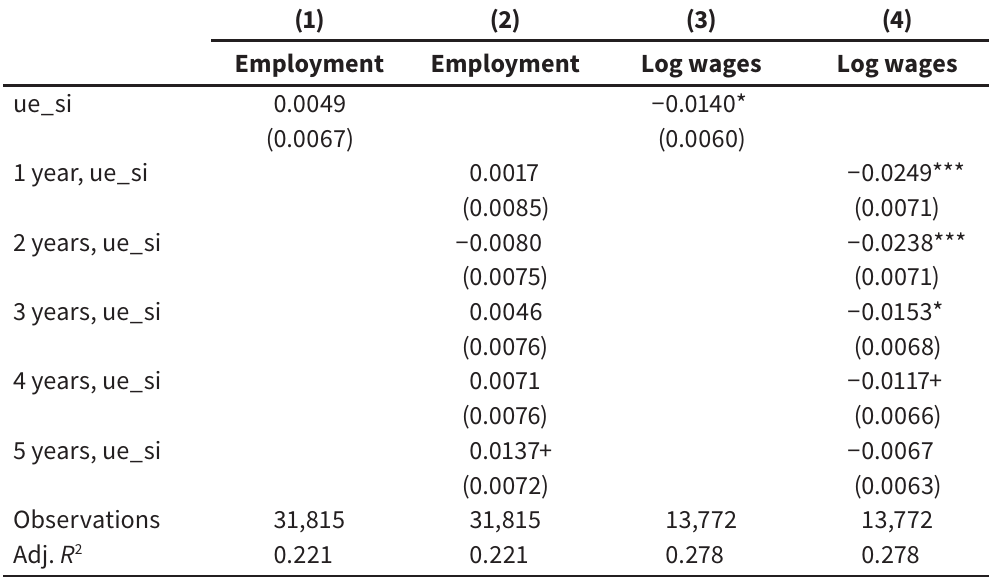
State unemployment estimates (1) (2) (3) (4) Employment Employment Log